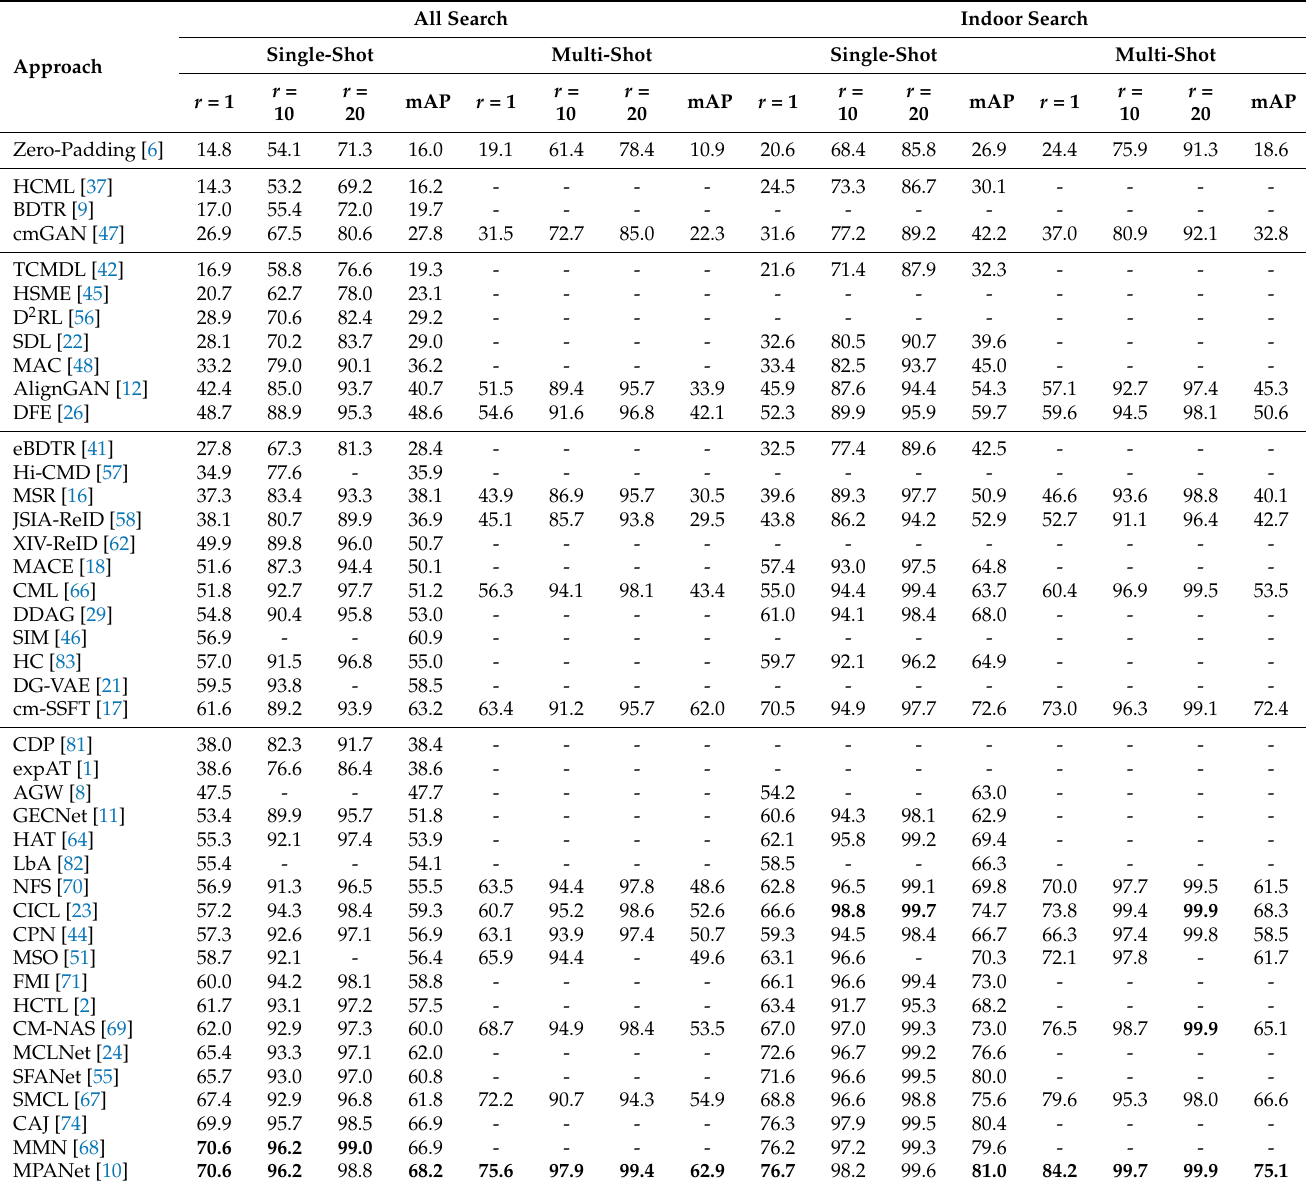
Table 3. Rank- r accuracy (%) and mAP (%) performances of state-of-the-art methods on SYSU-MM01. Bold numbers are the best